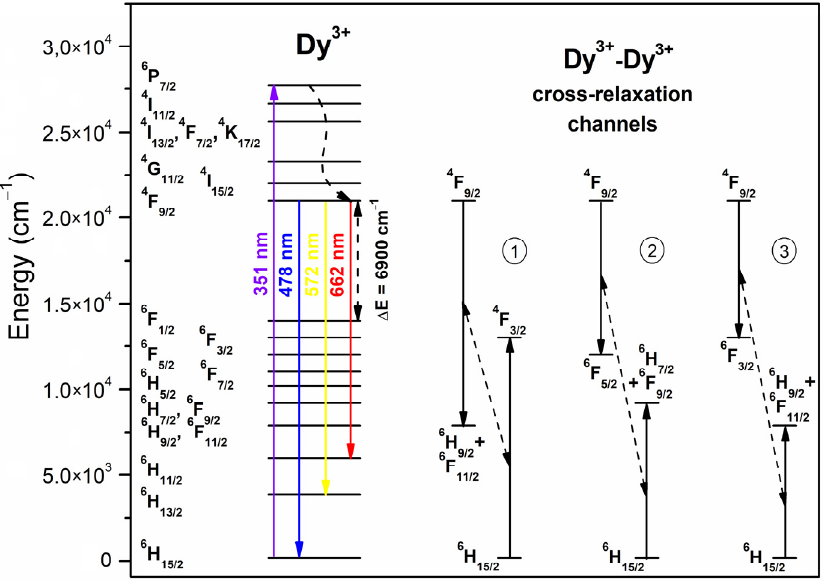
Figure 5. The energy level scheme of Dy 3+ along with the cross-relaxation (CR) channels.